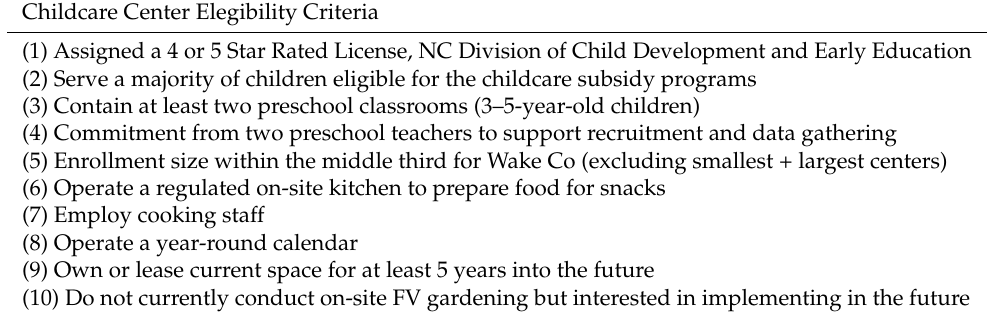
Table 1. Childcare Center Eligibility